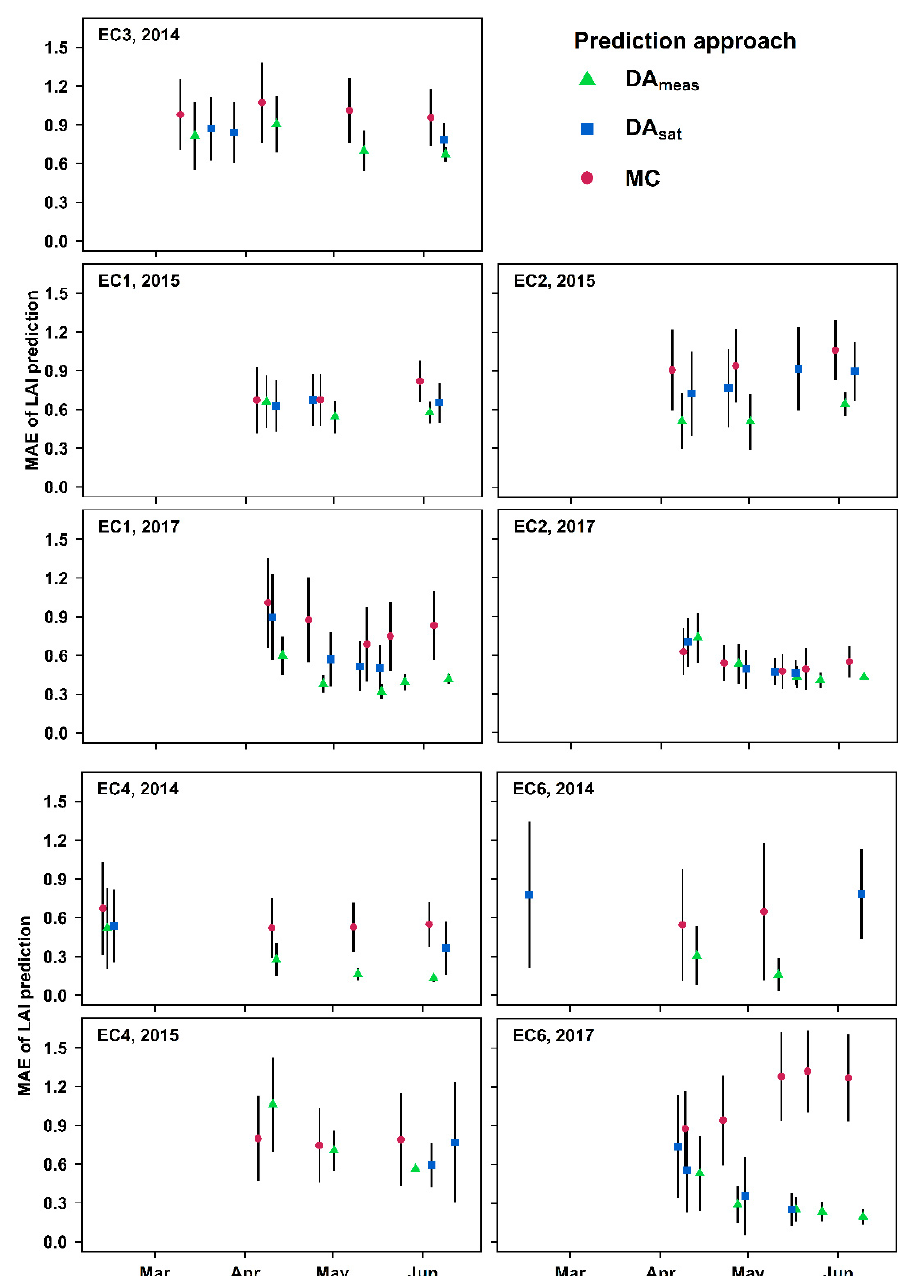
Figure 4. Mean Absolute Error (MAE) of LAI predicted with data assimilation and Monte Carlo simulation. Points and bars represent mean and standard deviation MAE of prediction ensembles. Red, green, and blue points show MC (Monte Carlo simulation), DA meas (data assimilation based on data measured in-situ), and DA sat (data assimilation based on satellite observations).